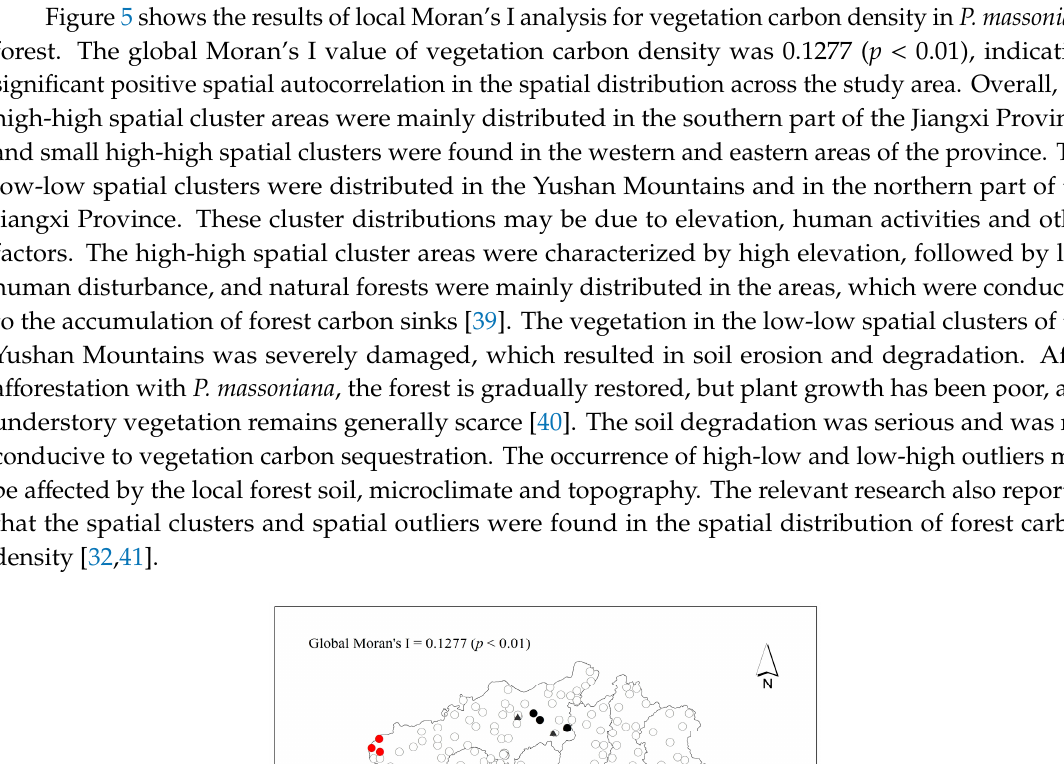
Table 5. Parameters of semivariogram models for vegetation carbon density (including tree, understory vegetation and litter layers) in Pinus massoniana forest in the Jiangxi Province. Model Type